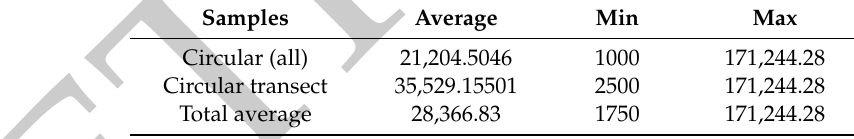
Figure 4. Sample cumulative metabolic rate schematic diagram. Table 2. Maximal, minimal, and average values for all samples.